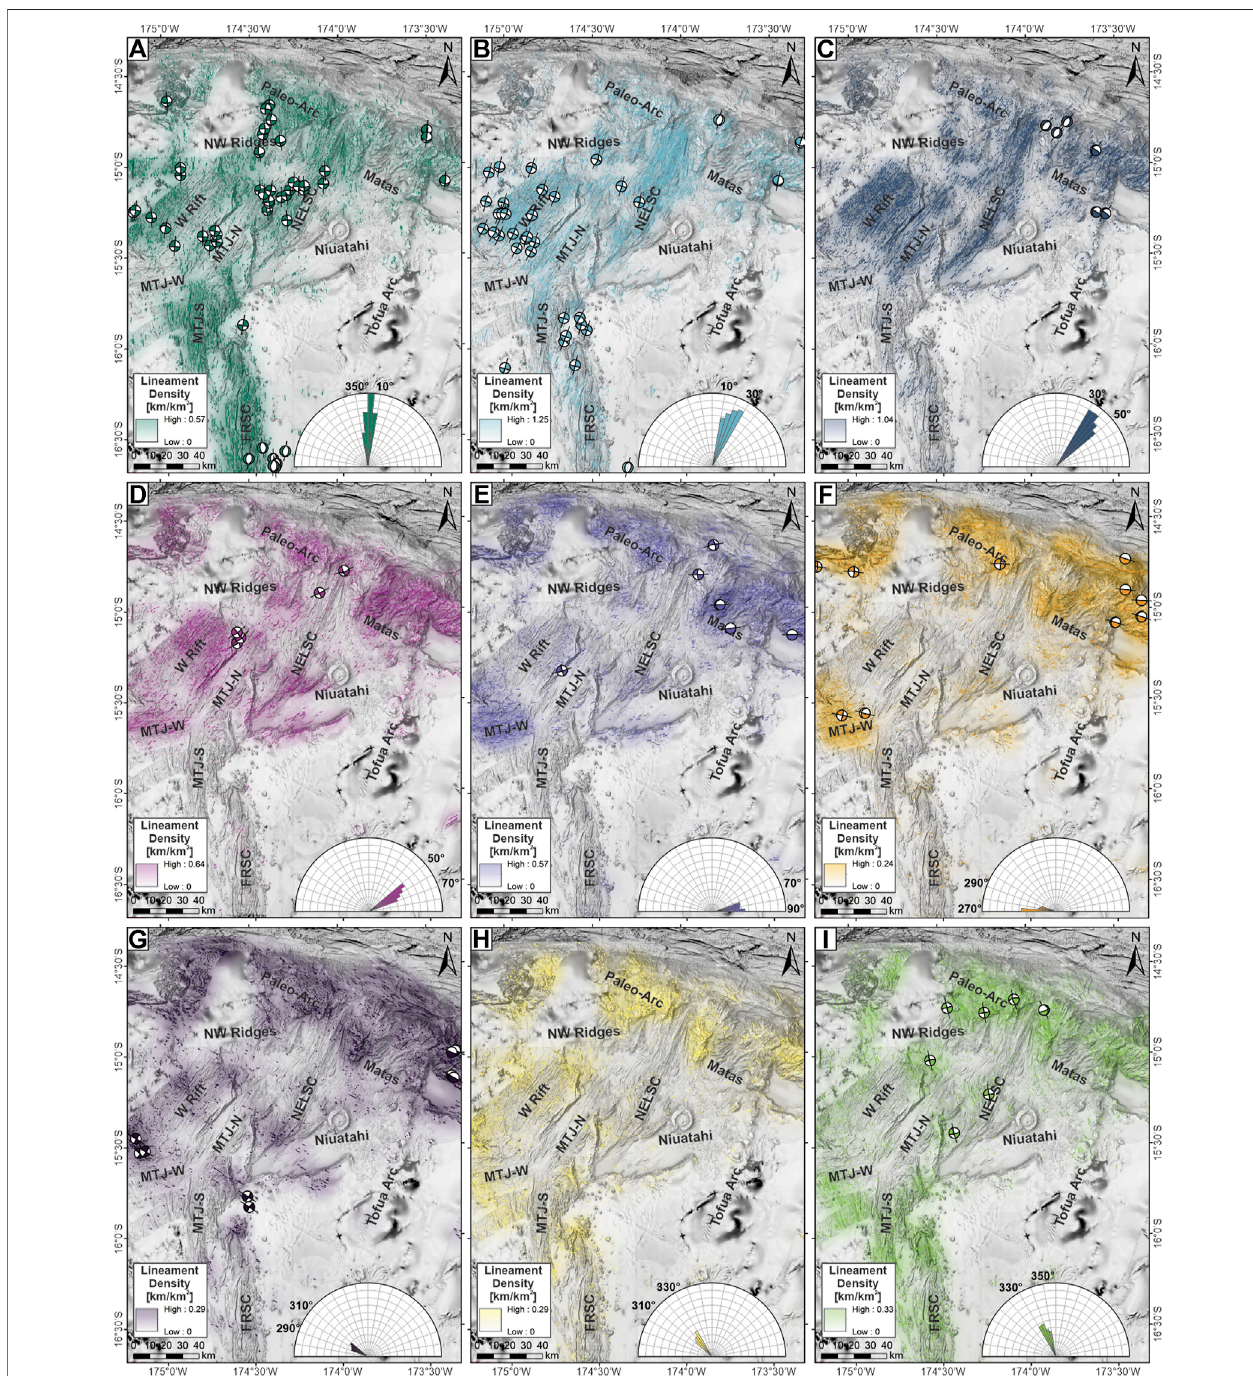
FIGURE7| Interpreted structurallineaments,withcolorshading representing relativelineamentdensities(lineamentkmperkm 2 ),andshallow ( ≤ 25 km) CMTfocal mechanisms from Harvard (www.globalcmt.org; Dziewonski et al., 1981; Ekström et al., 2012), classi fi ed according to interpreted focal plane solution: (A) N-trending (max. 0.57 km/km 2 ), (B) NNE-trending (max. 1.25 km/km 2 ), (C) NE-trending (max. 1.04 km/km 2 ), (D) ENE-trending (max. 0.64 km/km 2 ), (E) E-trending (max. 0.57 km/km 2 ), (F) W-trending (max. 0.24 km/km 2 ), (G) WNW-trending (max. 0.29 km/km 2 ), (H) NW-trending (max.0.29 km/km 2 ), (I) NNW-trending (max.0.33 km/km 2 ). Stereonets of CMTs grouped according to interpreted focal plane solution are shown in Supplementary Figure S4 , and close-ups of each of the maps are shown in Supplementary Figures S32 – S40 . Abbreviations as in Figure 2 , bathymetric compilation as in Figure 3 .